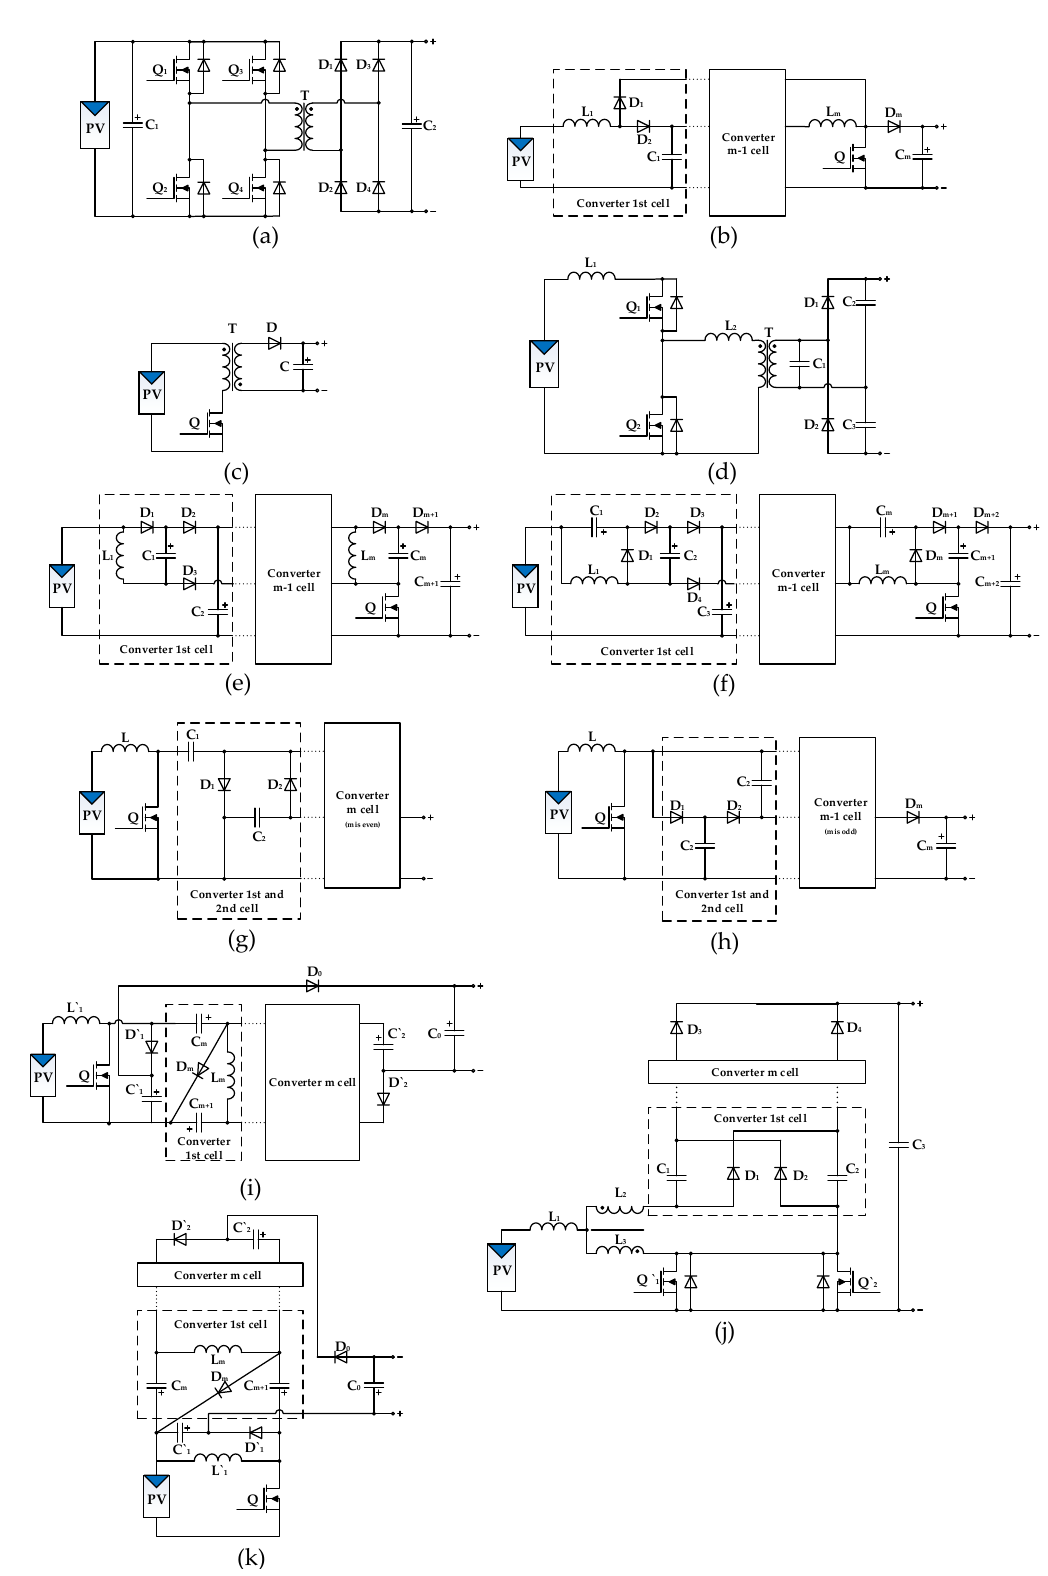
Figure 18. High voltage gain converters: ( a ) isolated full-bridge; ( b ) cascaded boost converter; ( c ) flyback; ( d ) LC parallel resonant converter with voltage doubler; ( e ) super lift voltage converter; ( f ) modified voltage lift converter; ( g ) Cockcroft – Walton multiplier based boost converter; ( h ) Dickson multiplier based boost converter; ( i ) boost derived MIESC SC-cell converter; ( j ) boost 3SSC cell converter; ( k ) buck-boost derived MIESC SC-cell converter.